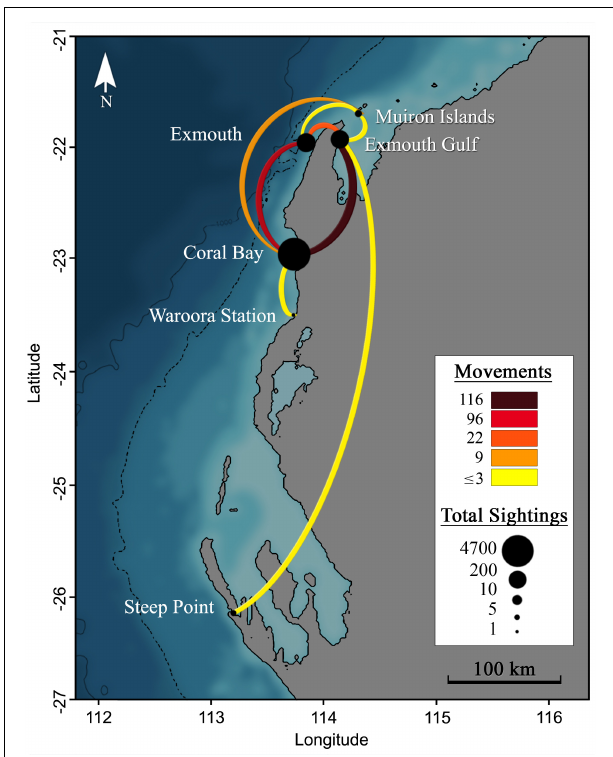
FIGURE 11 | Movements (lines) between locations (points) for M. alfredi in Western Australia, as detected through individual re-sightings from photographic identification. Lines show connections between re-sighting locations and the line colour indicates the number of movements detected. Point size indicates the total number of sighting records for a given location. The dotted and solid black lines to the left of the coastline represent the 500 m and 1000 m depth contours.